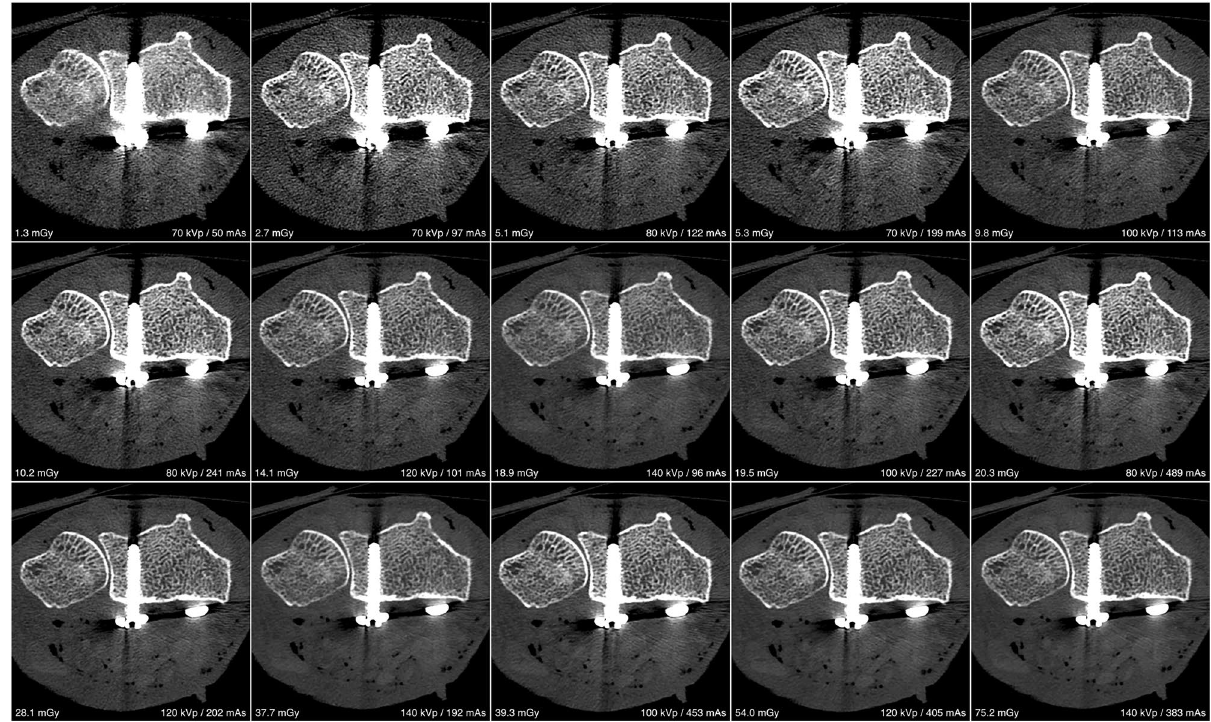
Figure 1. Bone image quality and intensity of metal artifacts by palmar plate osteosynthesis in conventional ultra-high-resolution MDCT scan protocols.